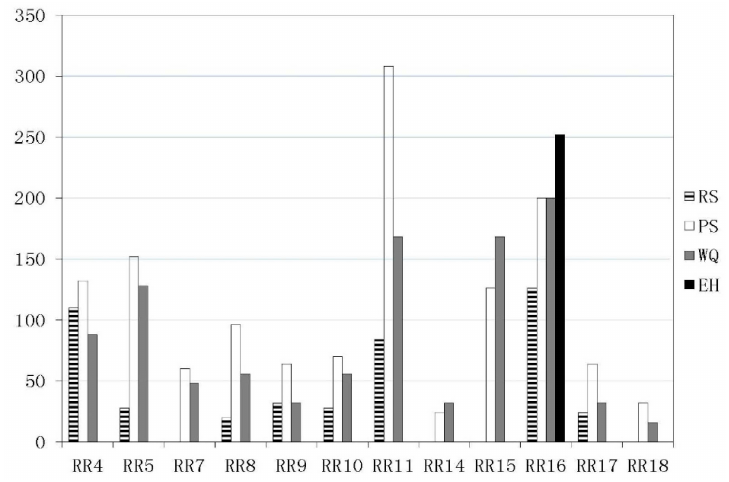
Figure 6. Risk score by each endpoint for sub-watersheds RR1-22 (excluding no-risk sub-watersheds). The abbreviations in the legend relate to risk assessment endpoints and are defined as follows: RS is resident safety; PS is property safety; WQ is water quality; and EH is ecosystem